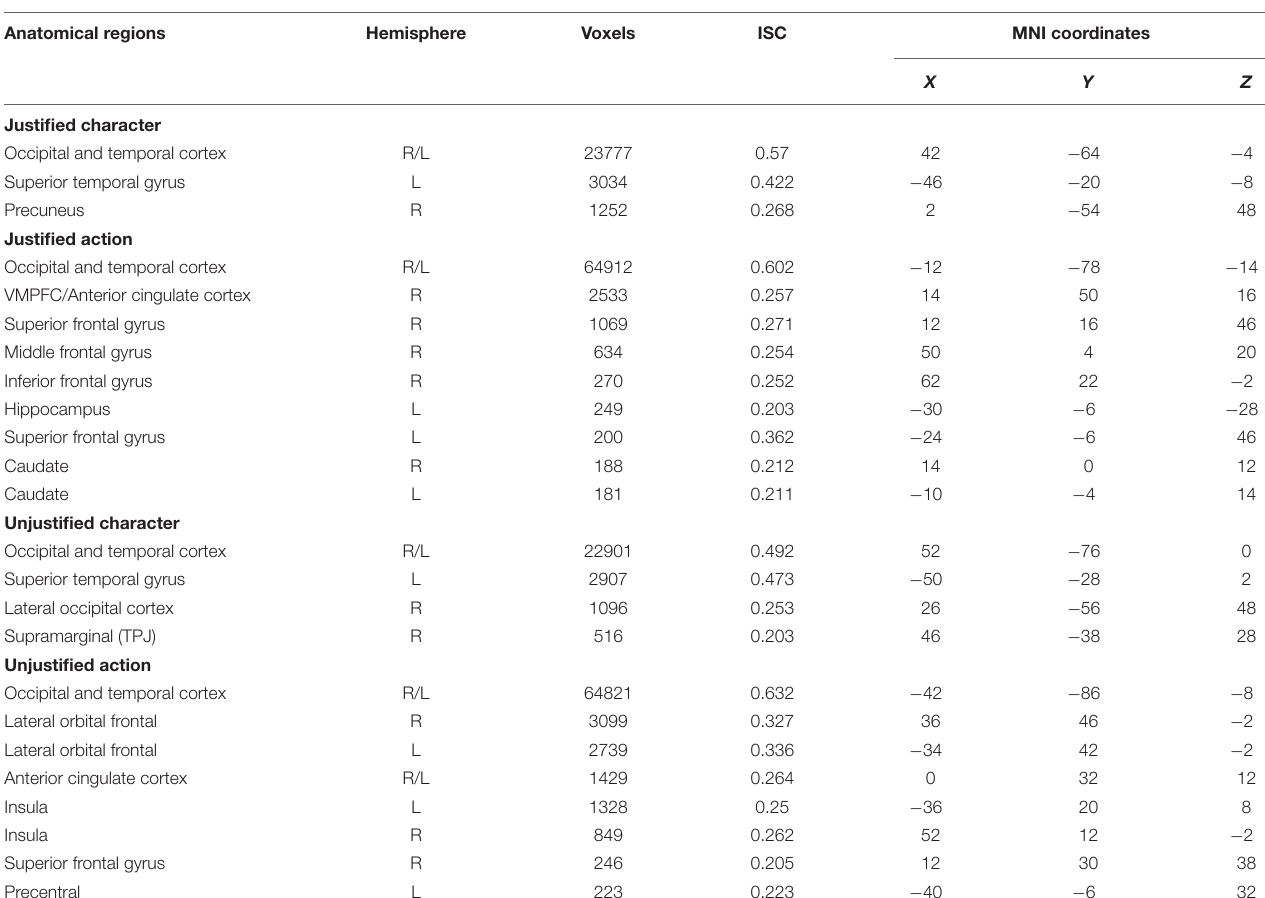
TABLE 2 | Character versus